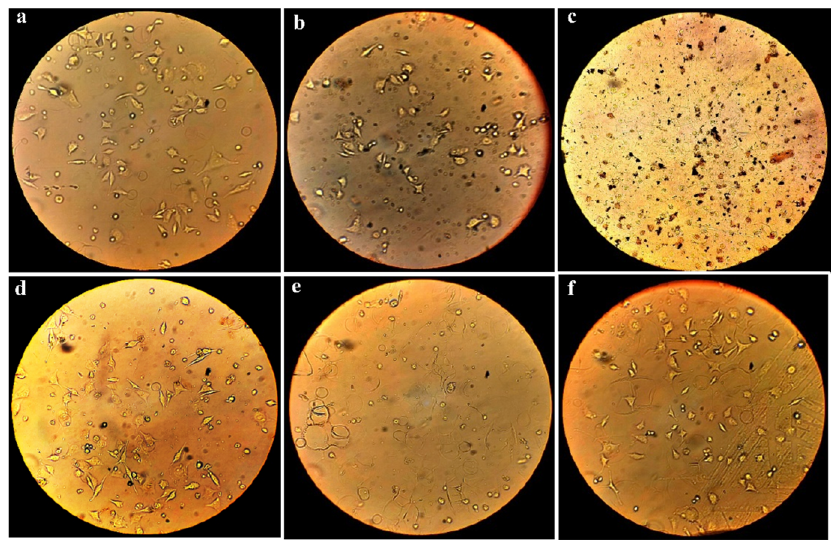
Figure 7. Microscopic images of cultured L929 cells on different media containing PBS as control ( a ) PLA/Gel ( b ), SNPs ( c ), PLA/SNPs ( d ), Gel/SNPs ( e ), and PLA/Gel/SNPs after 24 h ( f ). Transparent multi-branched objects are alive and healthy cells, spherical ones are low proliferated cells and dark spots are dead cells.